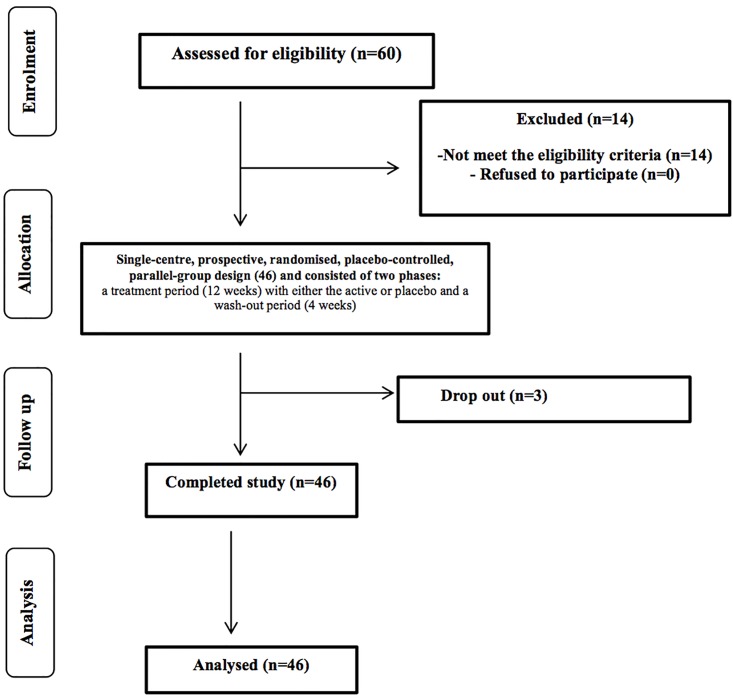
Flow of the study participants through the intervention.